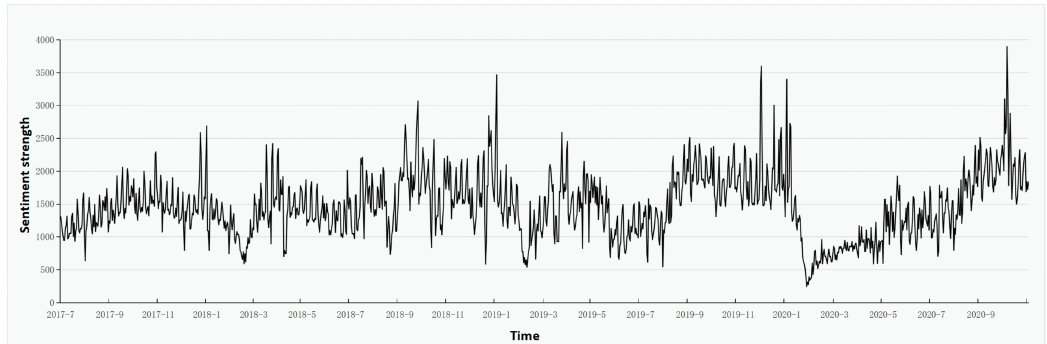
Figure 5. The dynamics of tourists’ daily sentiment